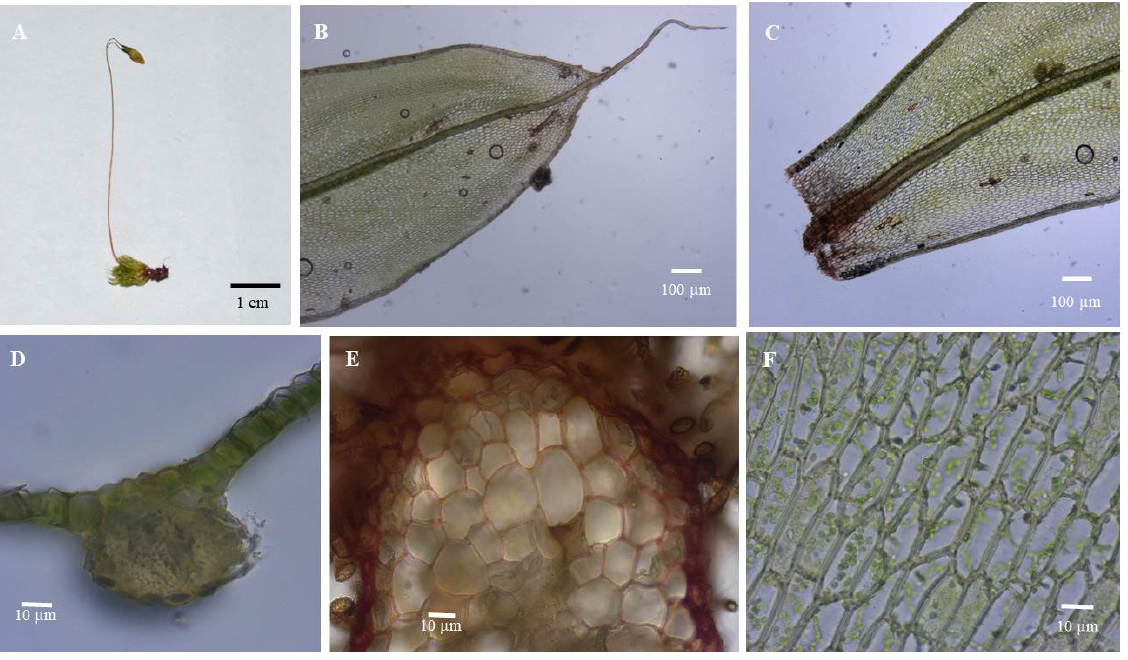
Figure 1: Brachymenium capitulatum A-Habit, B-Leaf apex with excurrent costa, C-Leaf base, D-Leaf cross section, E-Stem cross section, F-Median cells of the